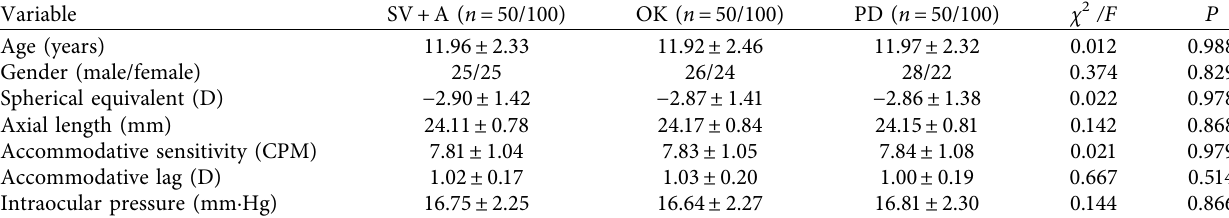
Table 1: Comparisons of the baseline characteristics of the included patients.